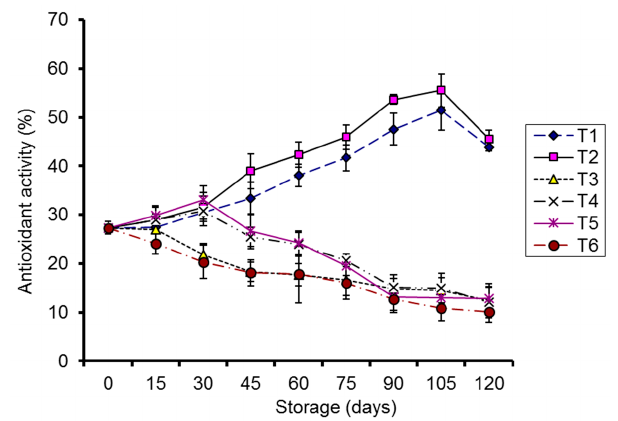
Figure 9. Effect of CMC and guargum-based silver nanoparticle coatings on the antioxidant activity of kinnow fruit stored at 4 and 10°C during storage. The vertical bars represent standard error of the means. Values represented as mean ± SE of three replicates.